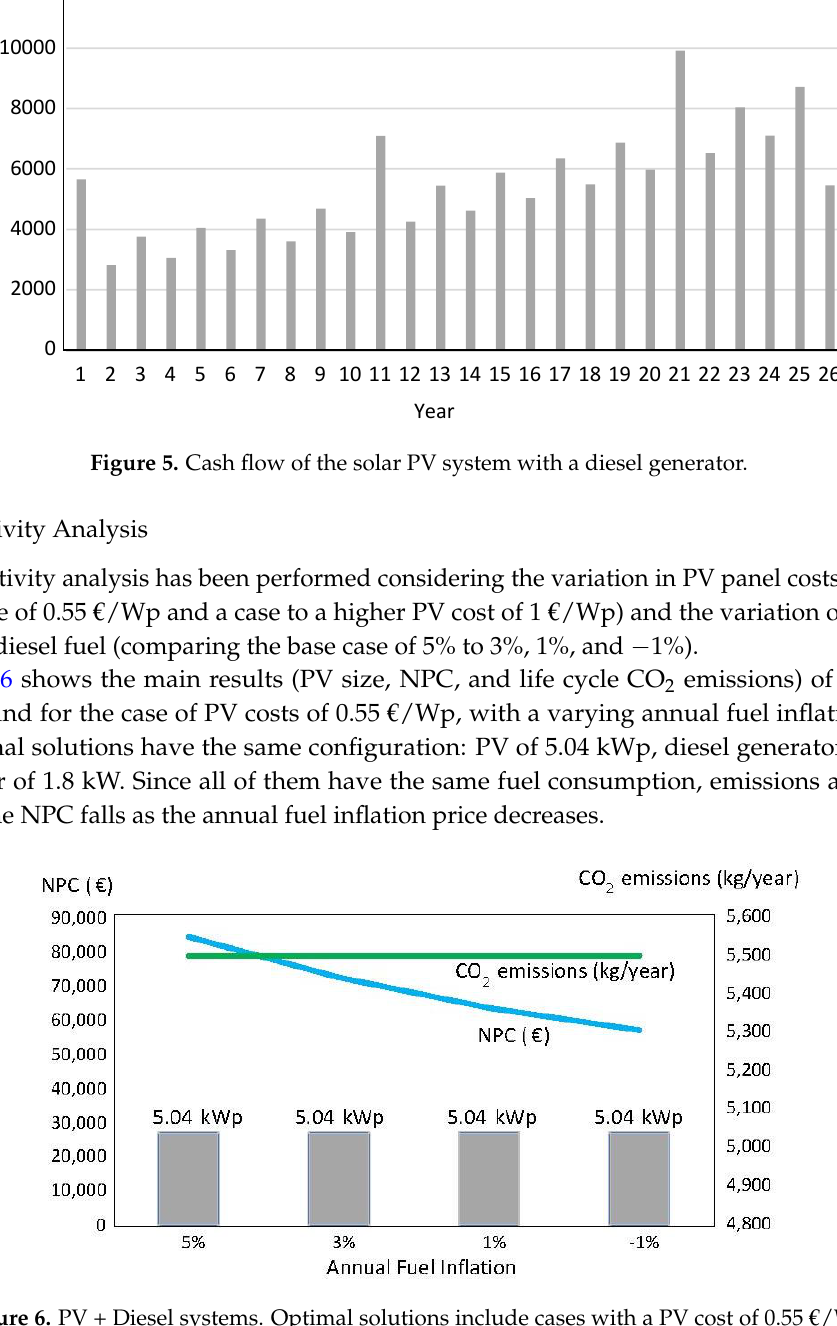
Figure 5. Cash flow of the solar PV system with a diesel generator.